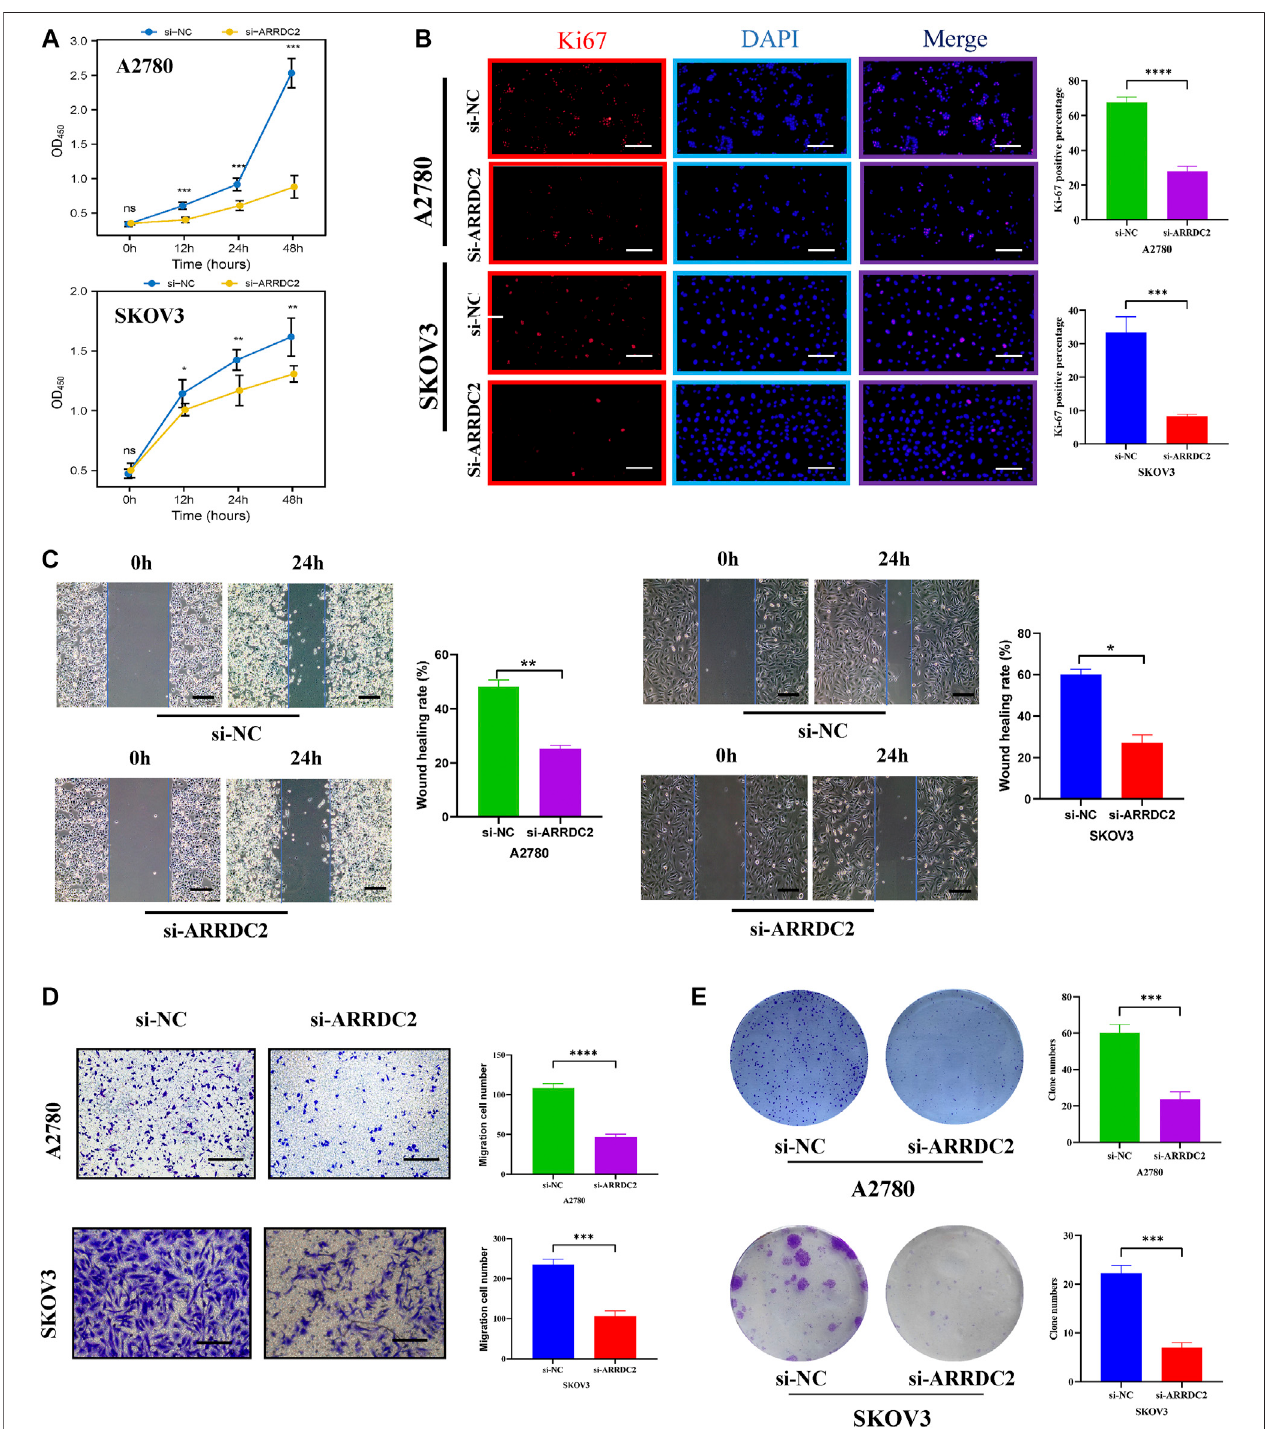
FIGURE9| EffectsofARRDC2geneknockdownonmalignantbiologicalbehaviorofOCcells. (A) CCK8experimentresultsofA2780andSKOV3celllinesaftercell transfection. The OD values measured at 450 nm wavelength at 0, 12, 24, and 48 h were displayed, which represented the cell proliferation rate. (B) Ki-67 immuno fl uorescence staining of A2780 and SKOV3 cell lines after cell transfection. (C) Wound-healing assay results and statistics ofOC cells after cell transfection. The wound-healing rate was measured at 0 and 24 h. (D) Transwell assay results and statistics of OC cells after cell transfection. The number of migrating cells was measuredat24 h,whichrepresentedtheabilitytomigrate. (E) TheresultsandstatisticsofcellcloneformationassayofA2780andSKOV3celllinesaftercelltransfection (* p < 0.05, ** p < 0.01, *** p < 0.001, **** p < 0.0001).